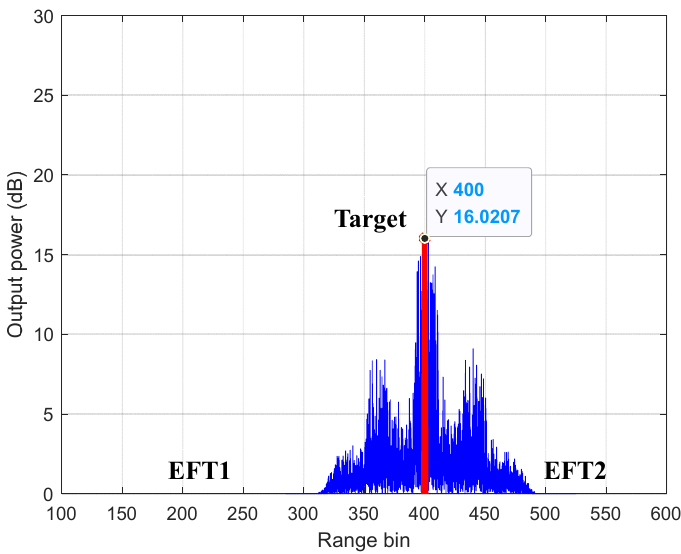
Figure 9. Analysis results of existing jamming range bin under range-angle two-dimensional MVDR adaptive beamforming.